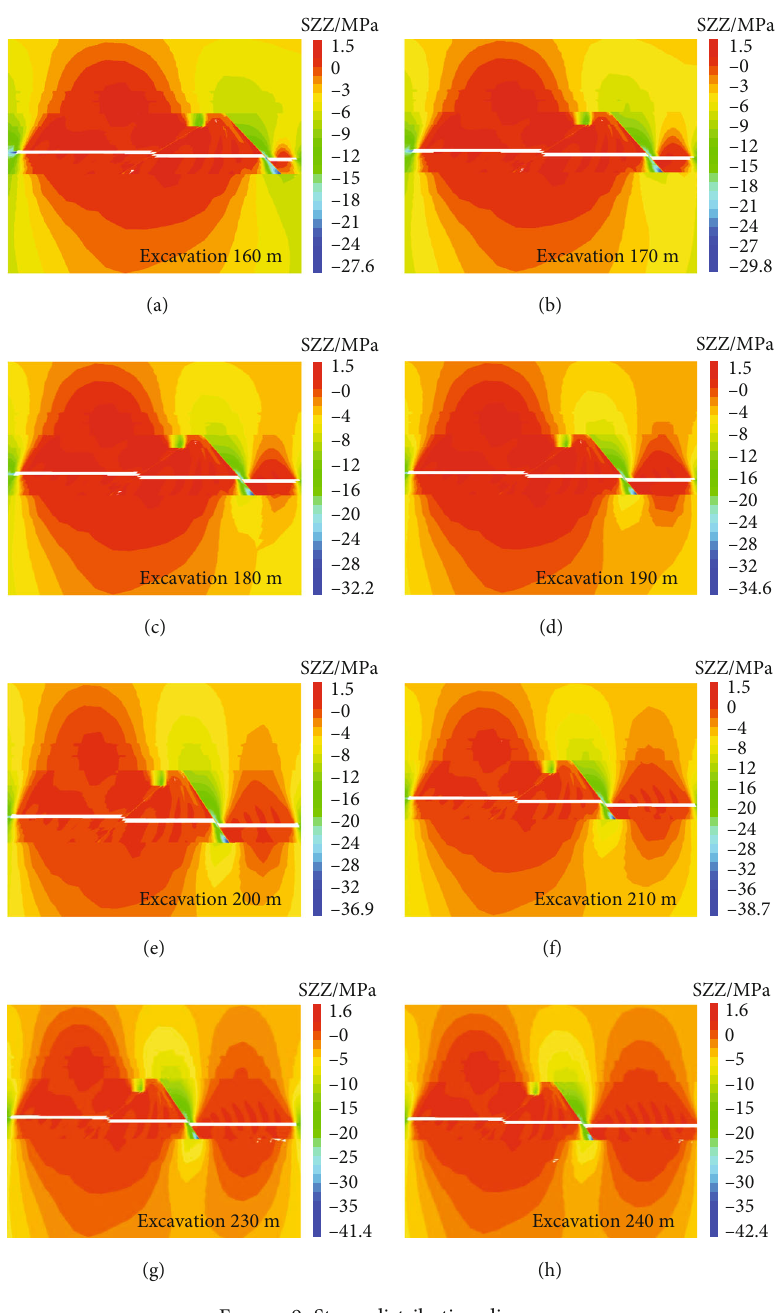
Figure 9: Stress distribution